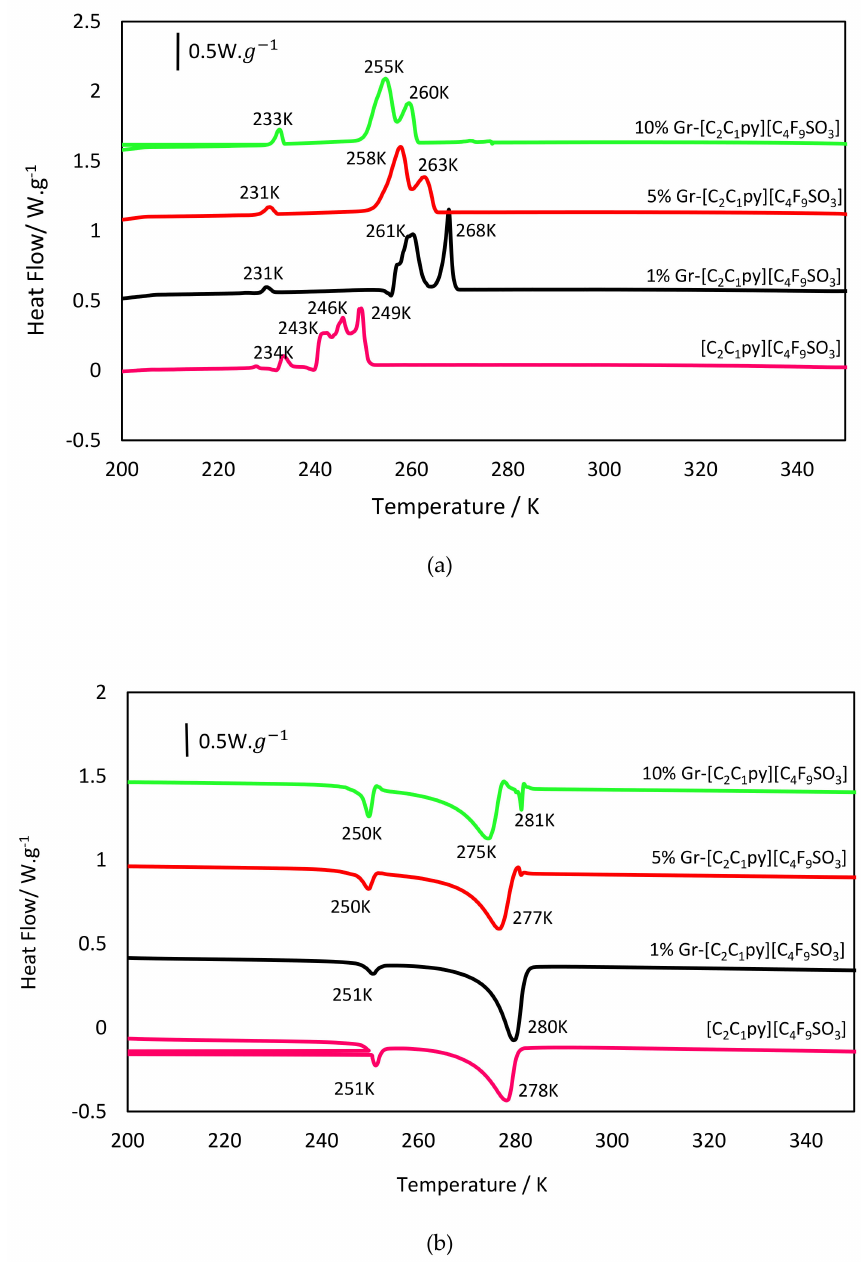
Figure 3. DSC thermograms of di ff erent concentrations of xGnP / [C 2 C 1 py][C 4 F 9 SO 3 ]; at 5 K · min − 1 . ( a ) Cooling scan, ( b ) heating